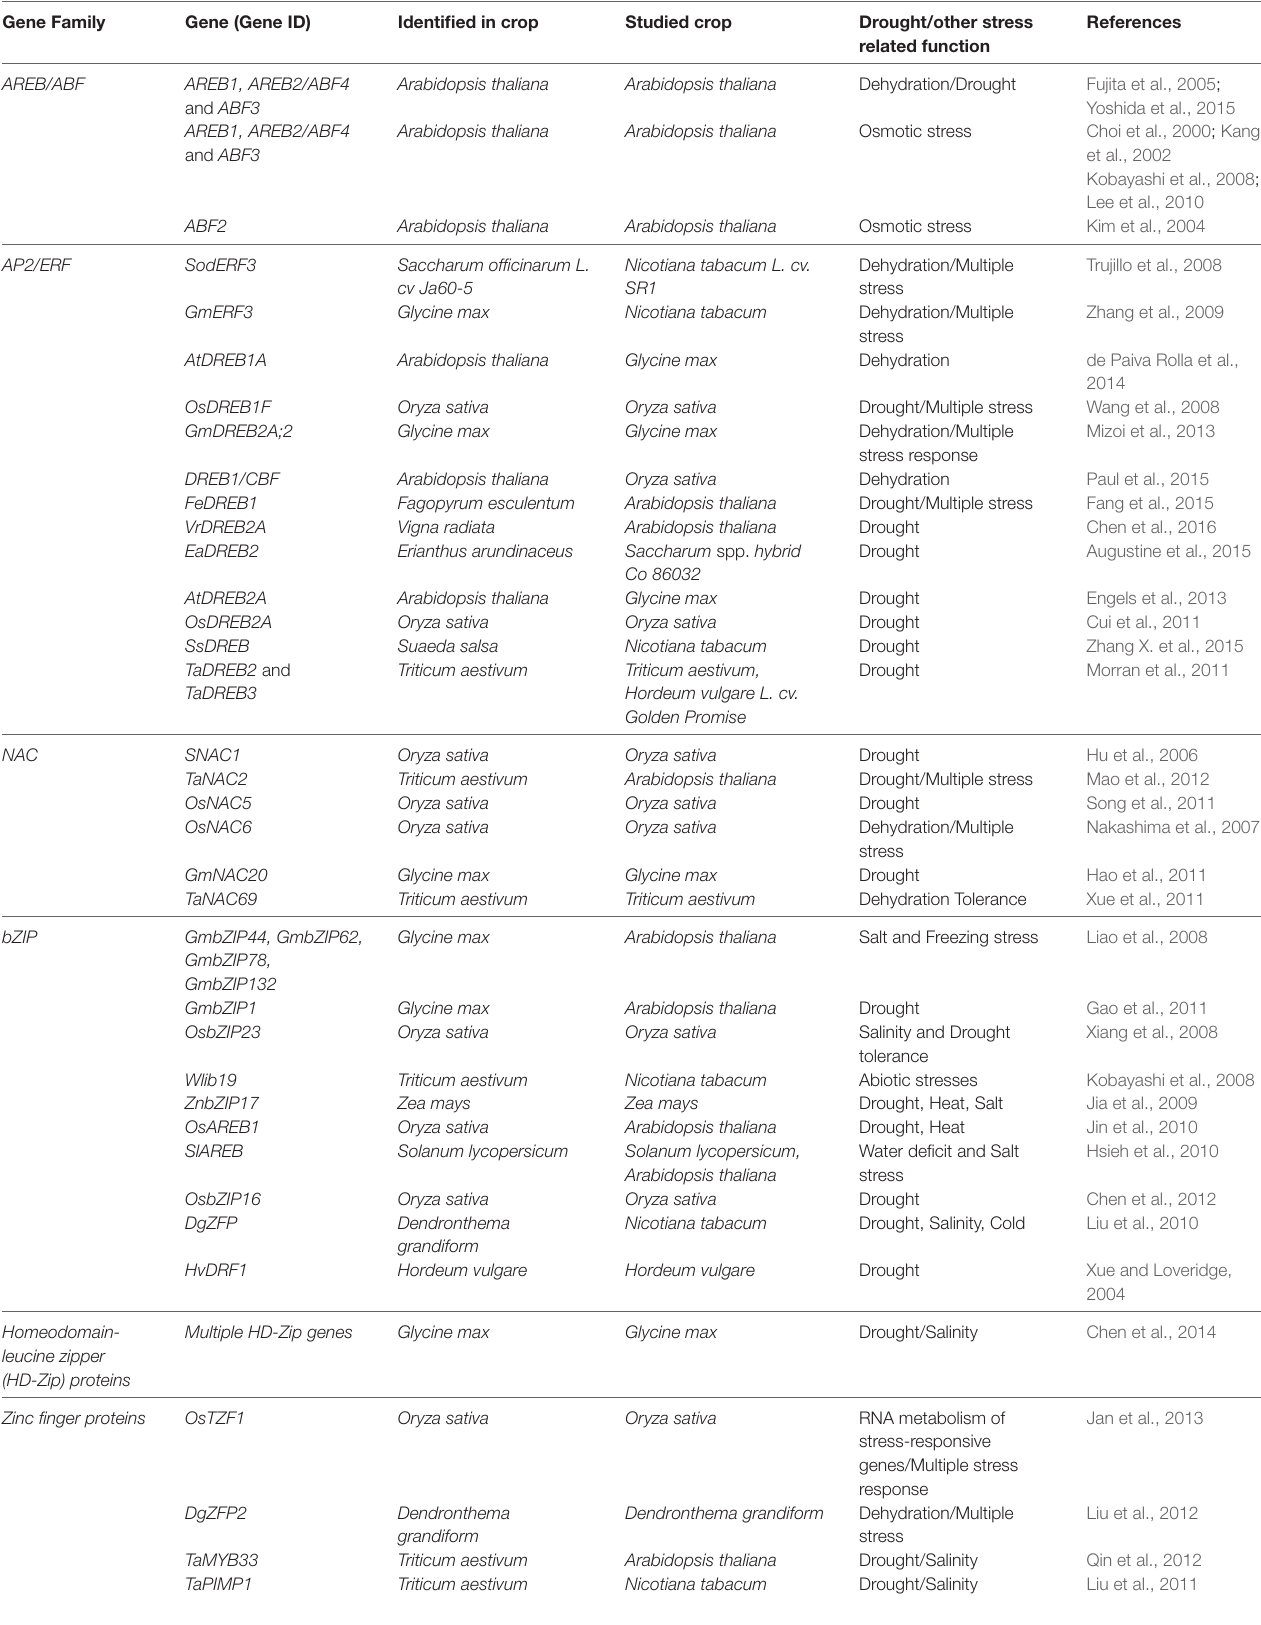
TABLE 1 | Major families of TF genes expressed in response to drought stress in plants. Gene Family Gene (Gene